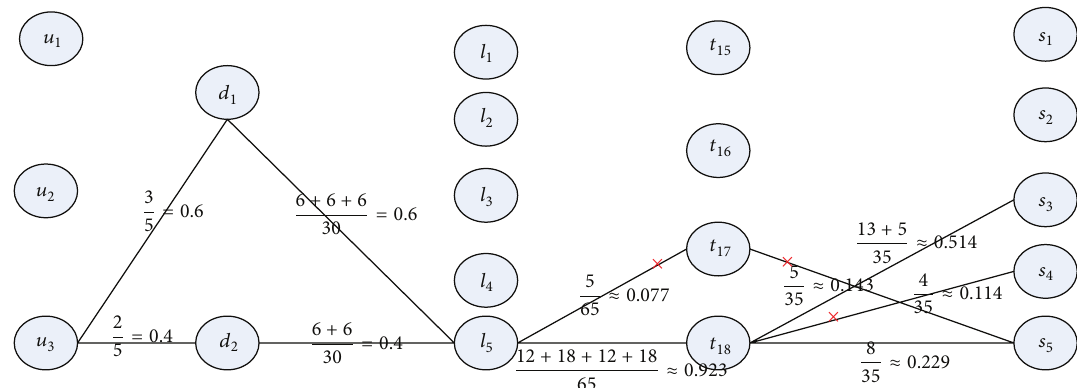
Figure 10: Calculate the tourist 𝑢 3 collection weight.